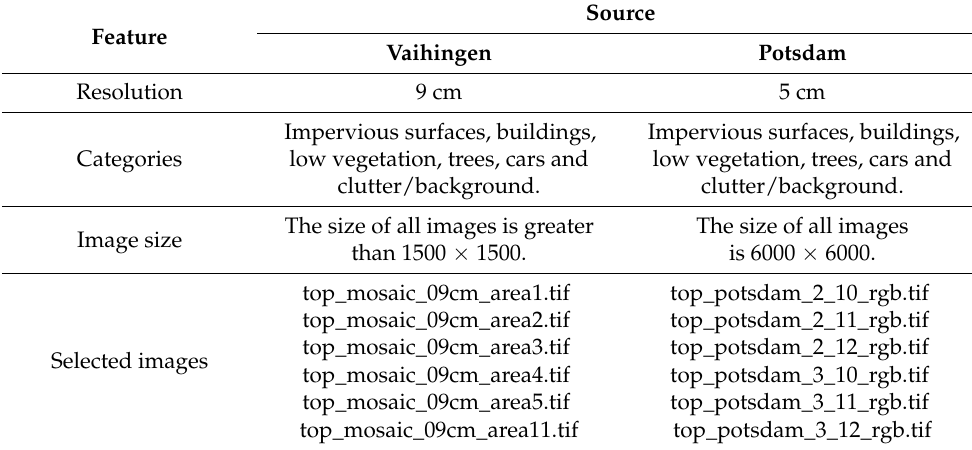
Table 1. Summary of the experimental image